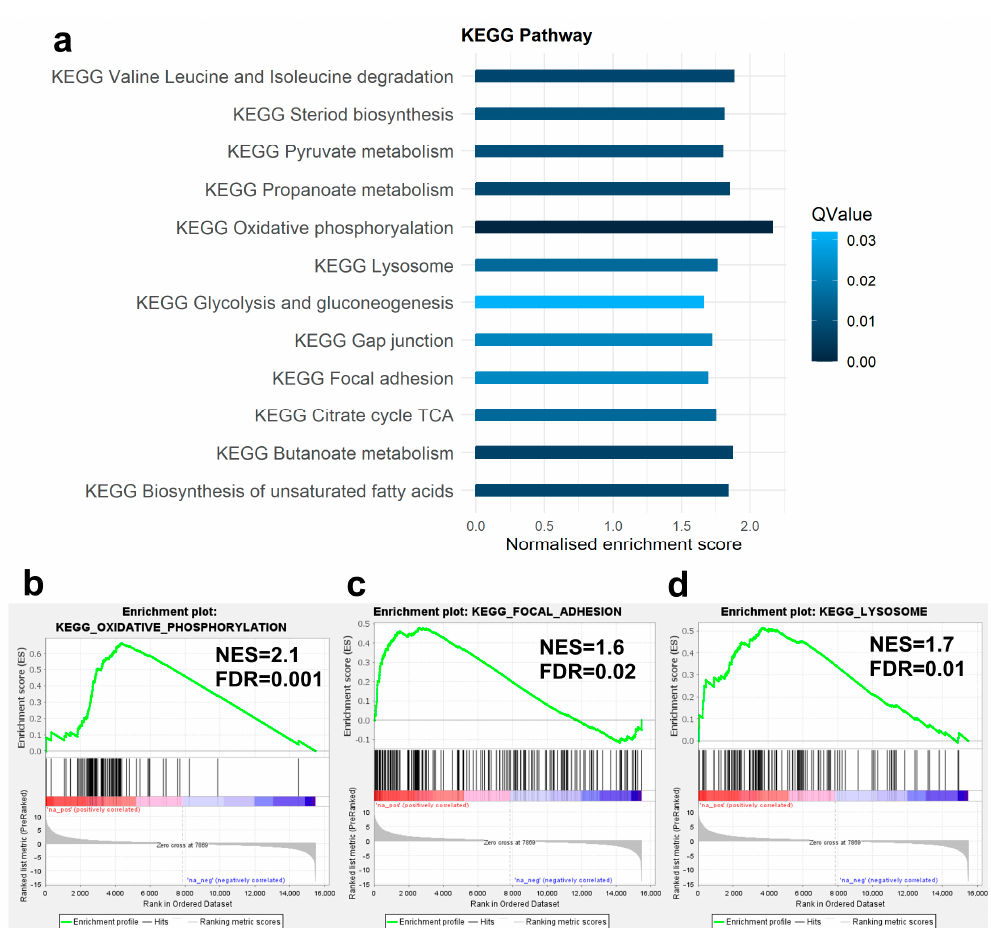
Figure 4. Results from the KEGG analysis performed using the GSEA software. ( a ) Bar plot displaying the results from the KEGG analysis. The GSEA plots ( b – d ) display gene sets that are enriched for upregulated genes in the OC group. Normalised enrichment score (NES) and false discovery rate (FDR) are presented.